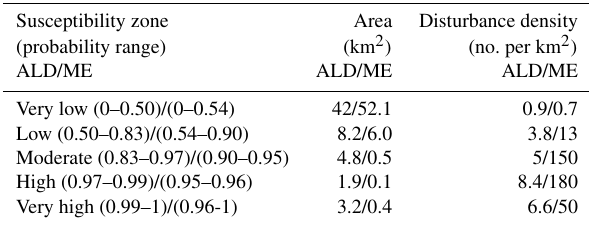
Table 3. Area and disturbance density of susceptibility